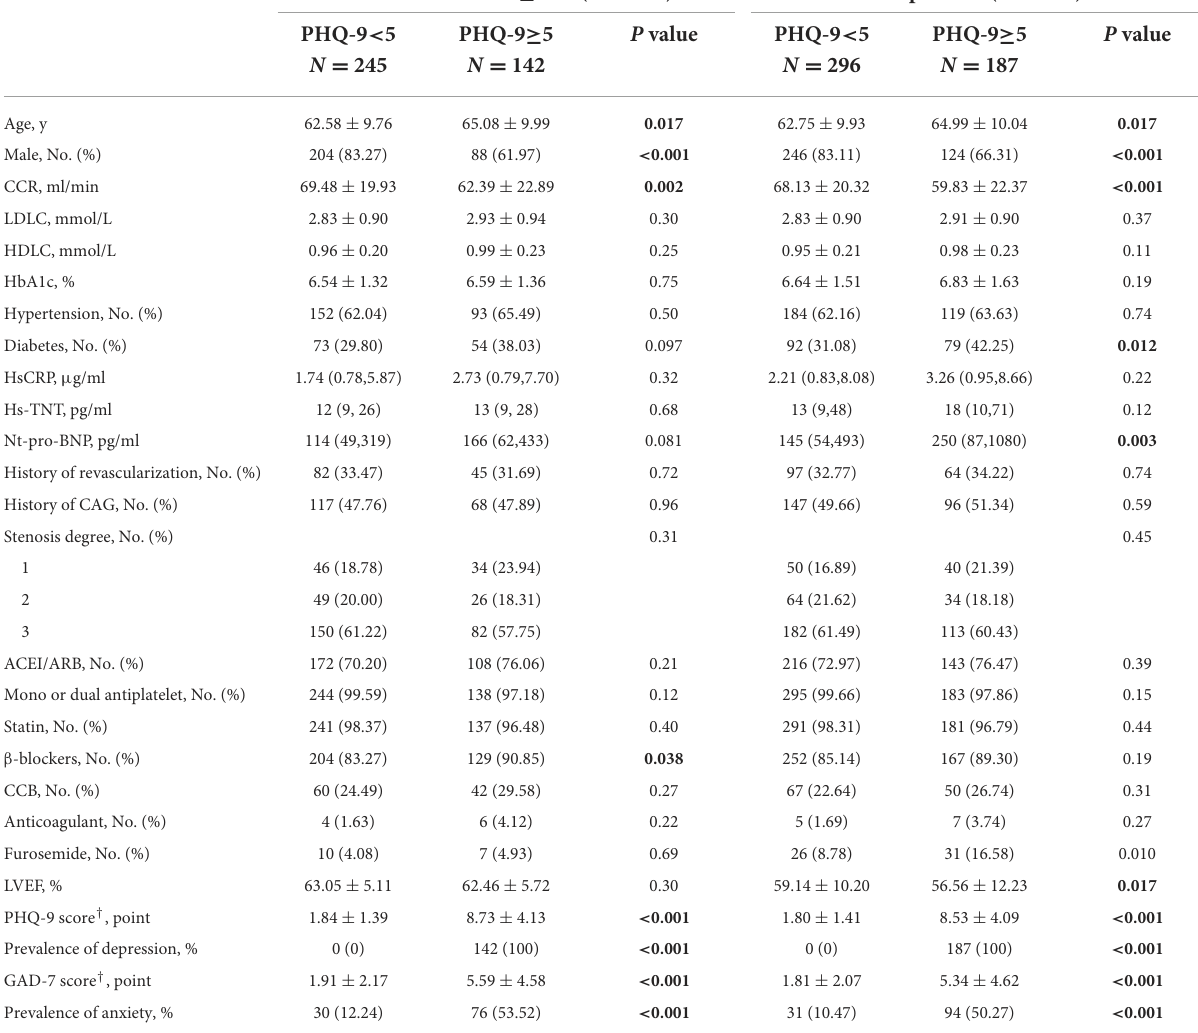
TABLE 2 Comparisons of baseline characteristics between groups categorized by depression in patients with LVEF ≥ 50% and in the whole population. Patients with LVEF ≥ 50% ( N = 387) All patients ( N =